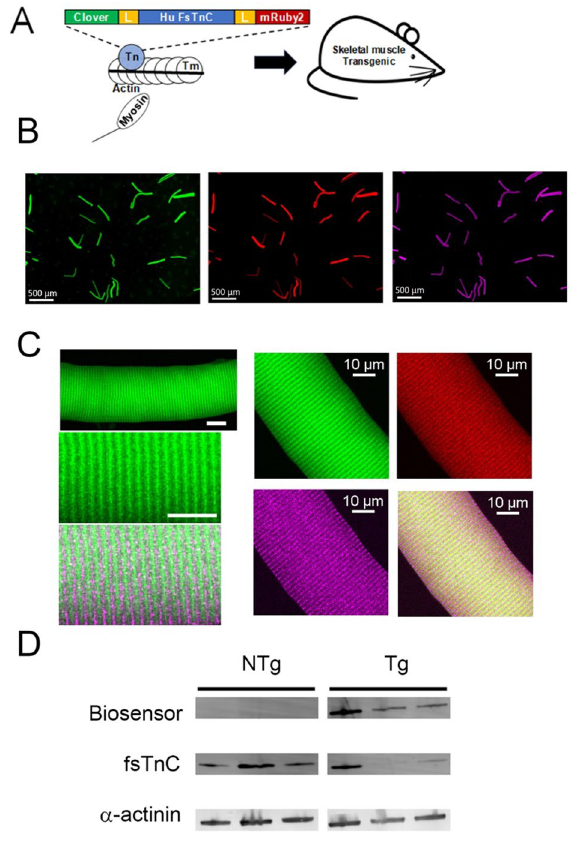
Figure 1. TnC biosensor transgene construction, localization, and expression. ( A ) The human fast skeletal muscle troponin C (h-fsTnC) cDNA was engineered and flanked on the 5’-end by a 19 amino acid flexible linker and the green fluorescent protein Clover and on the 3’-end by an 8 amino acid flexible linker and the red fluorescent protein mRuby2. ( B ) Low magnification immunofluorescence images of isolated FDB fibers demonstrating Clover (green) and mRuby2 (red) expression and α-actinin staining (purple) (scale bar = 500 μm). ( C ) High magnification immunofluorescence images of isolated FDB fibers. Left panel contains confocal images which show myofilament localization of the TnC biosensor (Clover-green, α-actinin – purple) (Top scale bar = 20 μm, bottom scale bar = 10 μm). Right panel images of same FDB fibers demonstrating co-localization of Clover (green) and mRuby2 (red) resulting in yellow (lower right panel) in correct orientation between Z-lines show by α-actinin staining (purple). ( D ) Western blot of fsTnC expression probed with anti-fsTnC antibody in transgenic EDL myofibers shows stoichiometric replacement of endogenous fsTnC (18 kDa) by the higher molecular weight biosensor fsTnC (72 kDa). The blot was also probed with an antibody for α-actinin (103 kDa) as a loading control. For clarity, the blot has been spliced to remove intervening non- specific bands. The full, labelled, blot is provided in the supplement (Supplementary Figs.1,